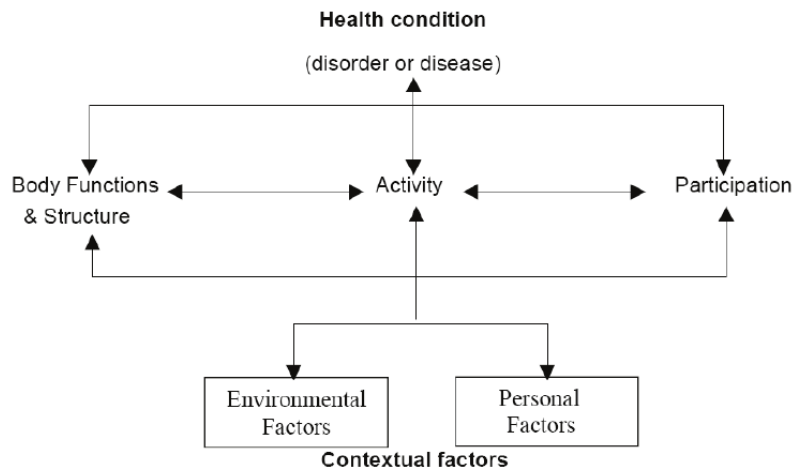
Figure 3. International Classification of Functioning, Disability, and Health (ICF) model [31].